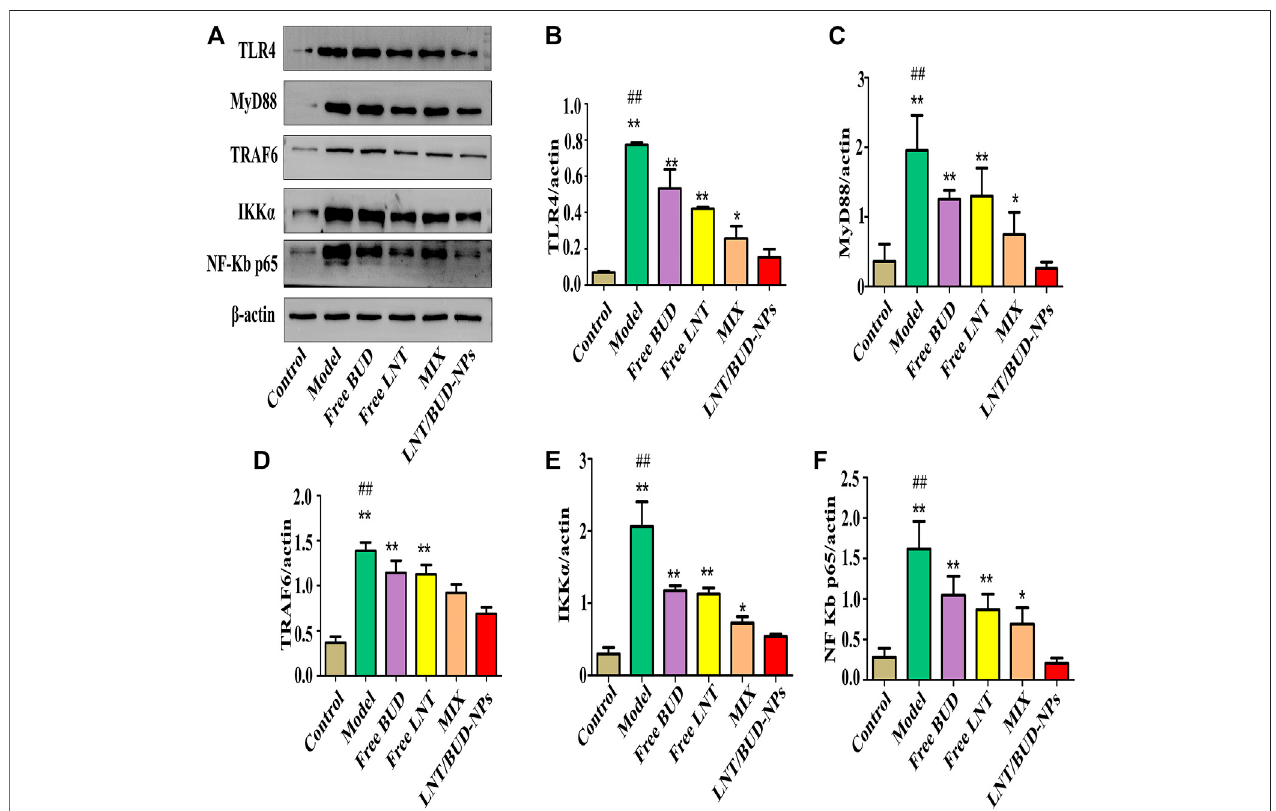
FIGURE7| Invivo anti-in fl ammatoryef fi cacybyinhibiting TLR4/NF- κ B signaling pathway among thedifferentformulas. (A) Westernblotimages ofNF- κ Bquantify protein concentrations by among the different formulas. (B – F) Histogram analysis of TLR4, MyD88, TRAF6, IKK α , and NF- κ B p65 expression in the colon among different formulas. * p < 0.05, ** p < 0.01 vs. LNT/BUD-NPs; # p < 0.05, ## p < 0.01 vs. Model; n (cid:1) 9.